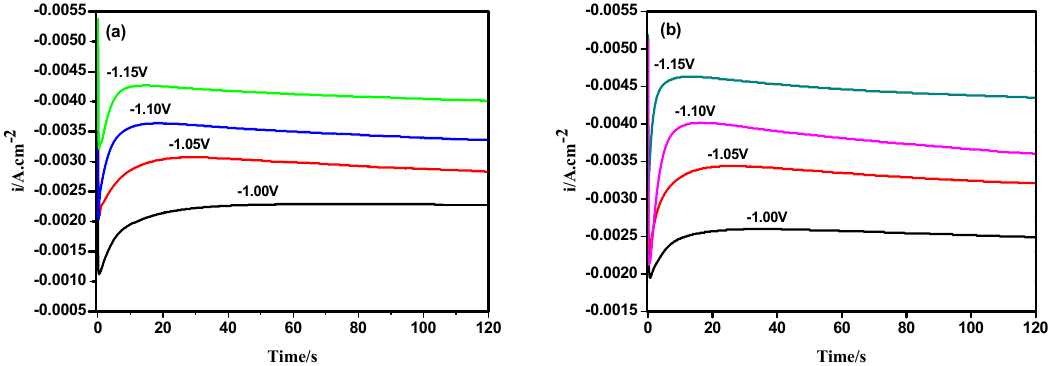
Figure 4. Chronoamperometry plots of both deposits measured under different potentials: ( a ) Ni; and ( b ) Ni-Y 2 O 3 , T = 40 °C, and pH = 4. Table 1. The values of the maximum cathodic current densities ( I m ) and nucleation relaxation times ( t m ) of both films according to Figure 4.